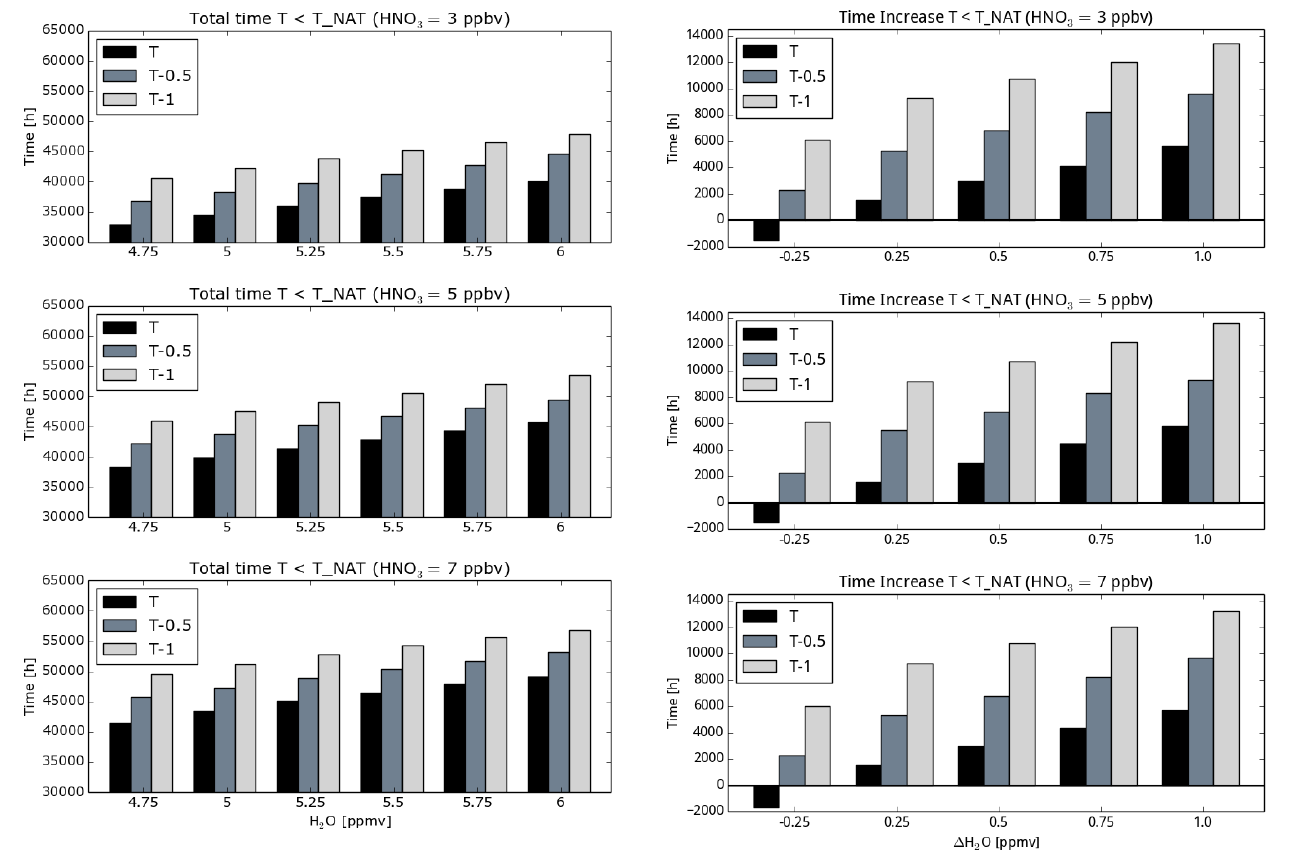
Figure 8. Histogram of increase in time where the temperature along the back trajectory is below the threshold temperature (sum over all 738 back trajectories) for a stratospheric H 2 O increase of 0.25, 0.5, 0.75 and 1.0ppmv, respectively, and for a stratospheric H 2 O decrease of 0.25ppmv. The calculation was performed assum- ing an HNO 3 mixing ratio of 3 (top), 5 (middle) and 7ppbv (bot-